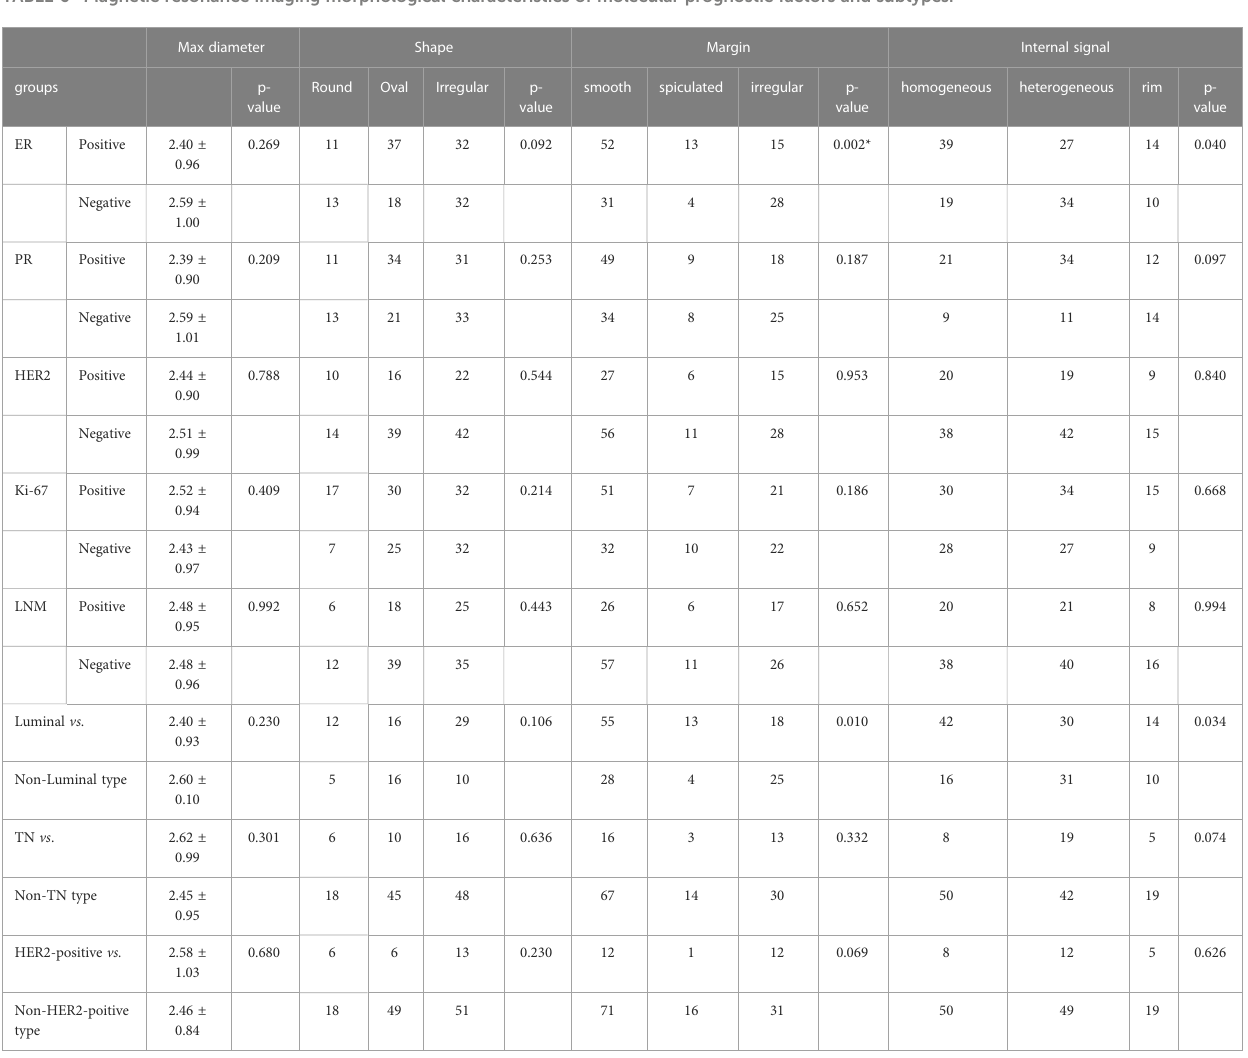
TABLE 6 Magnetic resonance imaging morphological characteristics of molecular prognostic factors and subtypes.